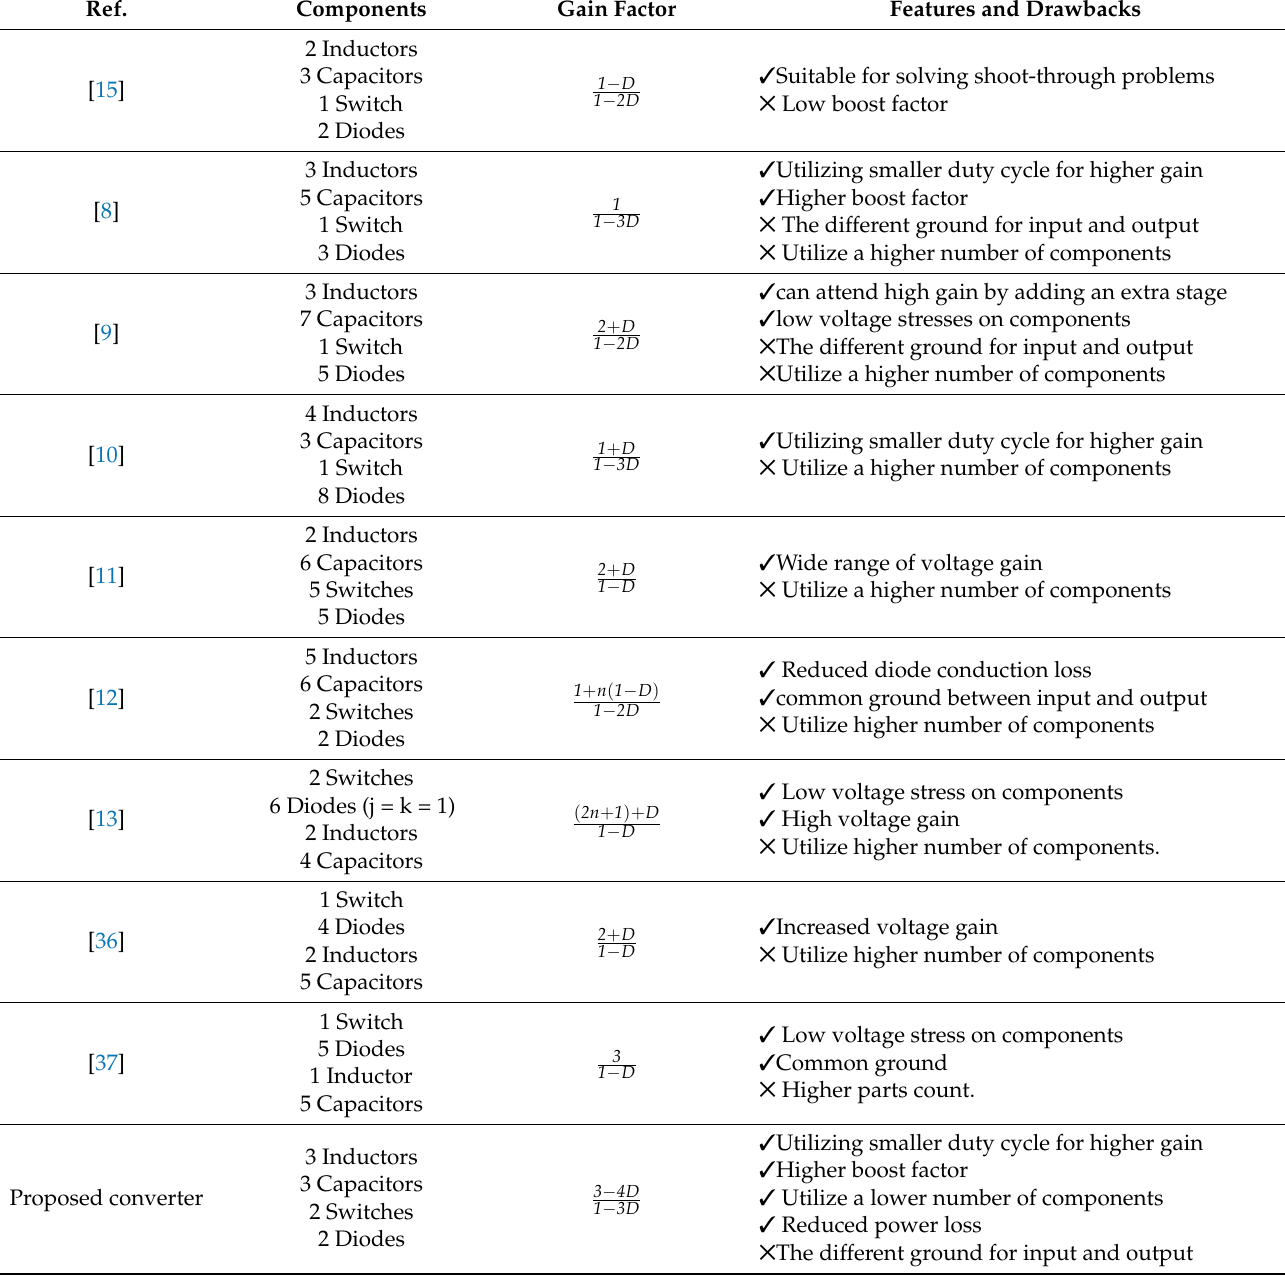
Table 3. Performance comparison of the proposed converter and existing converters.